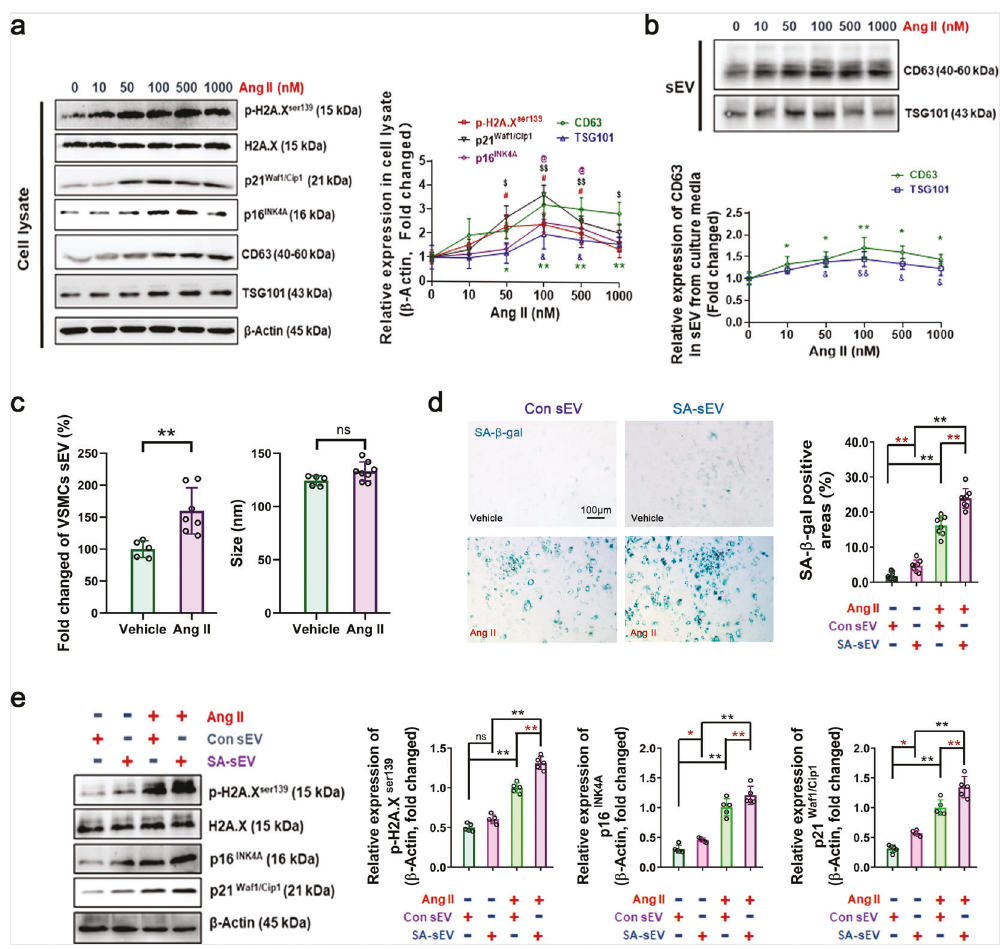
Fig. 4 Excess SA-sEVs was generated in senescent VSMCs and promote cell senescence under Ang II administration. a , b In vitro sEV biogenesis analysis in VSMCs. Three days after incubation with different concentrations of Ang II, the expression of senescence marker proteins (p-H2A.X ser139 , p21 Waf1/Cip1 , and p16 INK4A ) and sEV (exosome) marker proteins (CD63 and TSG101) in cell lysates and sEVs, respectively, were analyzed by western blot assay ( n ≥ 5, two-way ANOVA, * p < 0.05, ** p < 0.01). c The quantity and size of the sEVs derived from VSMCs were analyzed by NanoSight tracking assay. sEVs were extracted from VSMC culture medium and analyzed by a NS300 instrument ( n ≥ 5, one- way ANOVA, * p < 0.05, ** p < 0.01). d , e SA-sEVs promoted Ang II-induced senescence. VSMCs were treated overnight with SA-sEVs derived from senescent cells. Then, Ang II (100 nM) was added and maintained for 3 days. VSMC senescence was analyzed by ( d ) SA- β -gal staining and ( e ) western blot analysis of aging-related proteins. The cells were stained and the proteins were analyzed ( n ≥ 5, one-way ANOVA, * p < 0.05, ** p <